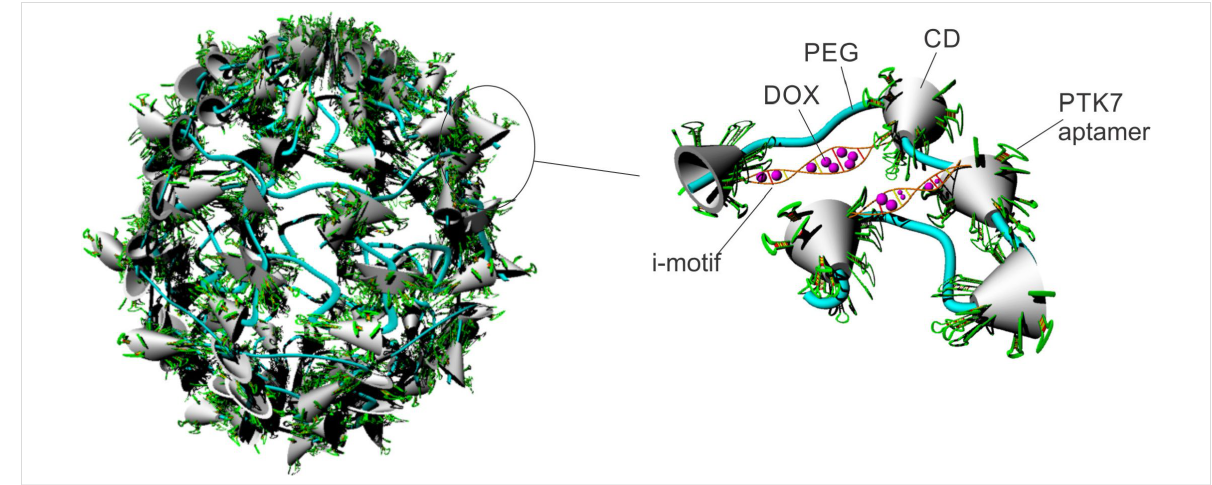
Figure 2: Schematic representation of a polyrotaxane nanoconstruct bearing surface-oriented PTK7 aptamers for targeted delivery of doxorubicin (PEG: poly(ethylene glycol), CD: cyclodextrin, DOX: doxorubicin). The dynamic structure allows for ligand “sliding” for efficient receptor binding and selective DOX release from the DNA i-motifs at lower pH values. Adapted from